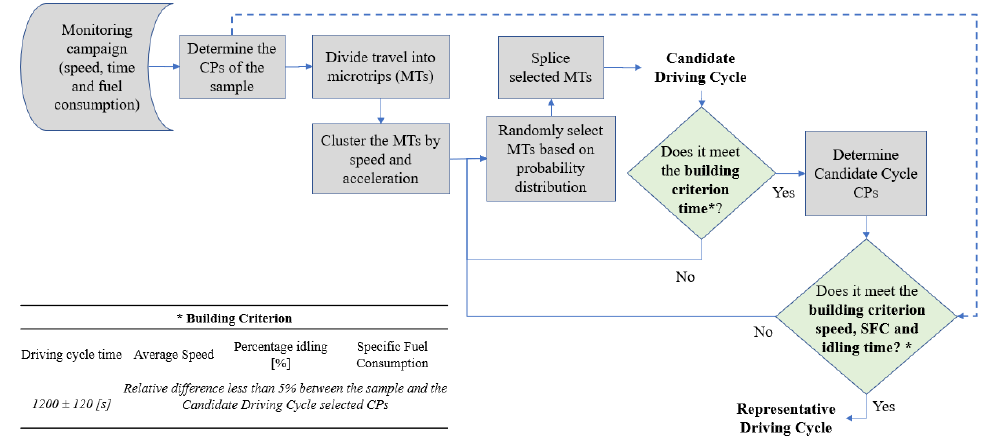
Figure 3. Energy-Based Micro-Trip method used to construct representative driving cycles. Authors’ elaboration based on [40].